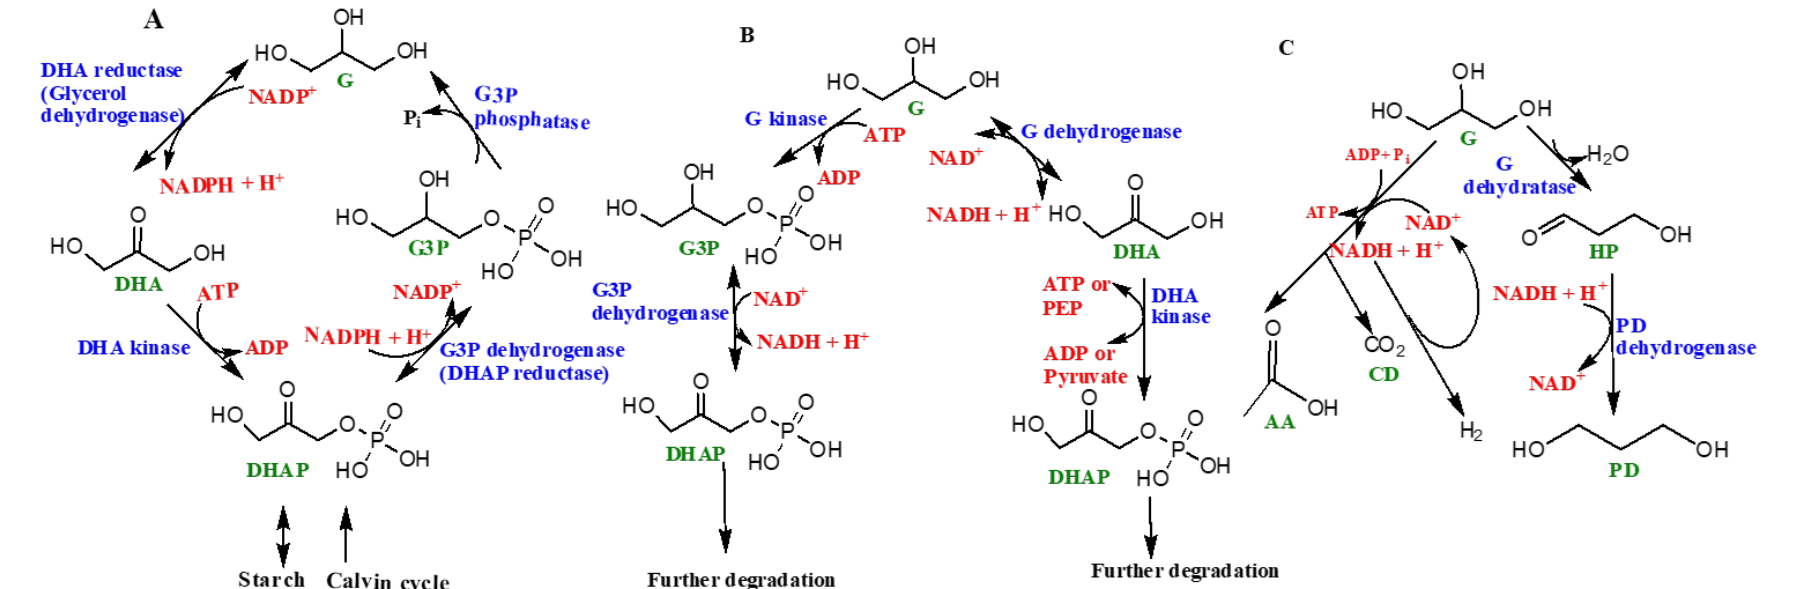
Figure 5. Schematic diagram showing the role of glycerol in various living organisms: ( A ) ‘glycerol cycle’in the genus Dunaliella , ( B ) glycerol’s metabolic pathways in aerobic heterotrophic prokaryotes, and ( C ) fermentation of glycerol in Halanaerobium saccharolyticum . The abbreviations used are as follows: G (glycerol), DHAP (1,3-dihydroxyacetone phosphate), G3P ( sn -glycerol-3-phosphate), DHA (1,3-dihydroxyacetone), PEP (phosphoenolpyruvate), HP (3-hydroxypropionaldehyde), PD (1,3-propanediol), AA (acetic acid), CD (carbon dioxide), and H 2 (hydrogen gas). Enzyme names are shown in blue while organics (products or reactants) are shown as green, and co-enzymatic or high energy molecules (such as PEP) based reactions are shown as red. For more information see [47]. Figure reproduced, redrawn (with minor modifications) with permission from [47]; Copyright ©2017 John Wiley and Sons.